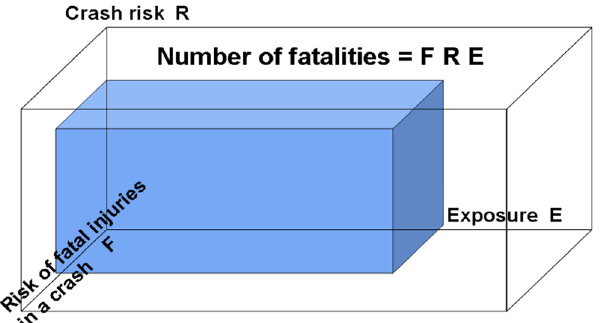
Fig. 2 The dimensions of road safety